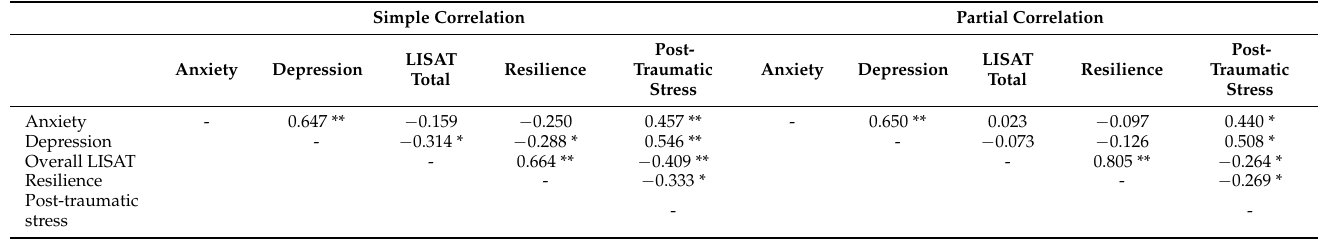
Table 3. Correlations between anxiety, depression, and post-traumatic stress and satisfaction with